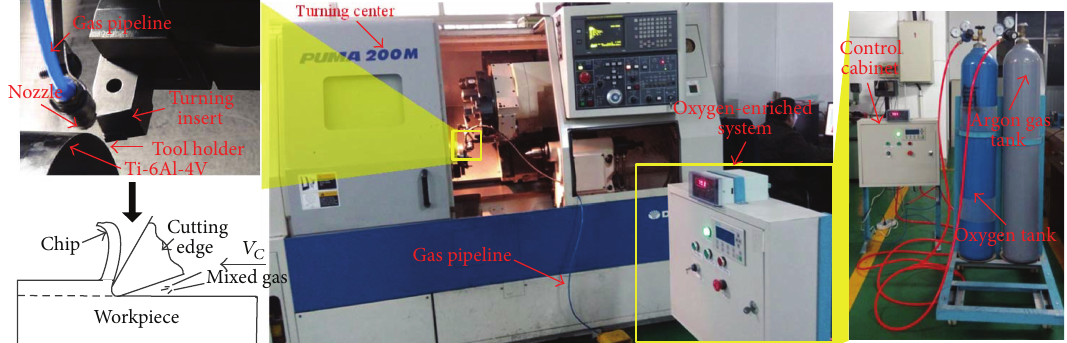
Figure 1: Turning-experiment apparatus in an oxygen-rich atmosphere.